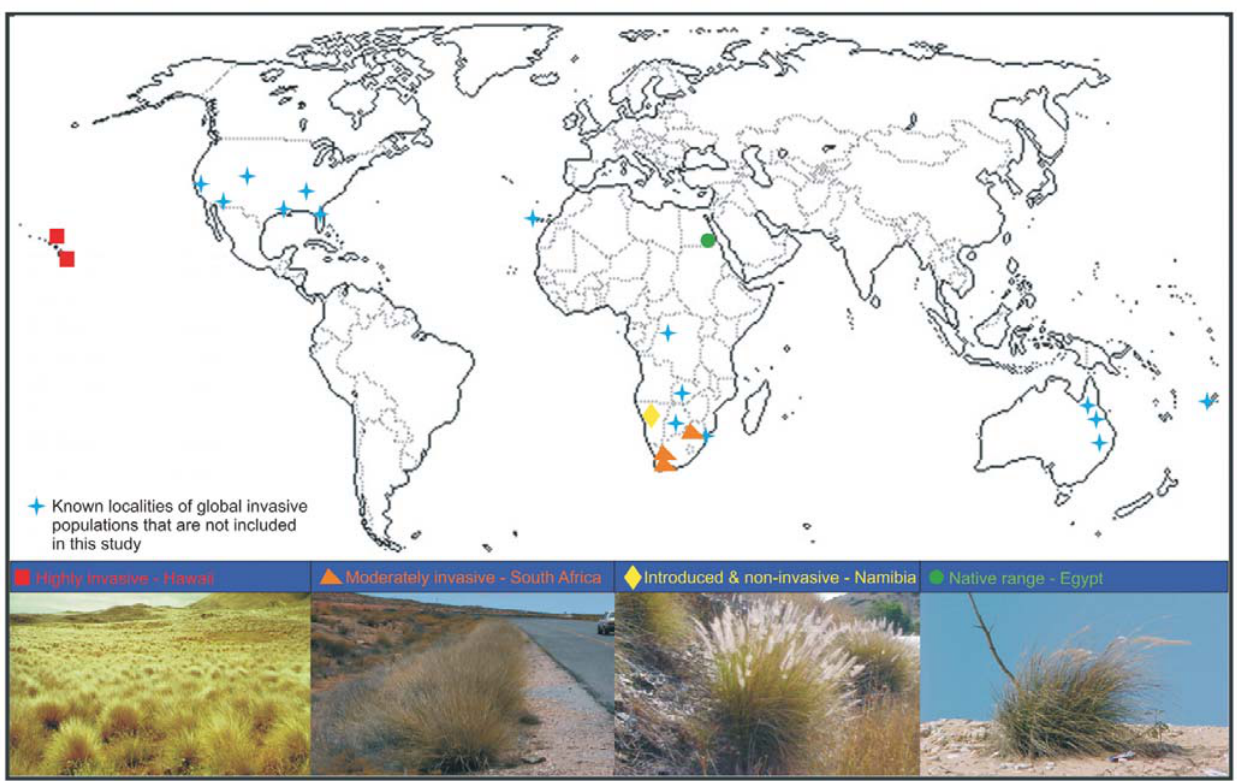
Figure 1. Global locations where differentially invasive and native range populations of Pennisetumsetaceumwere collected for this study. Additional world locations where fountain grass has been introduced and are considered invasive are also indicated.